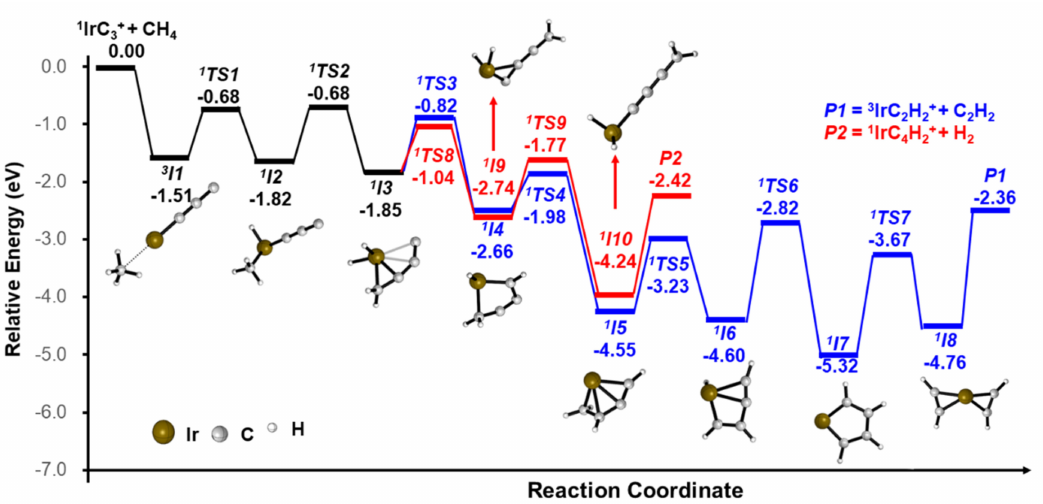
Figure 2. Reaction pathways for generating IrC 2 H 2+ /C 2 H 2 (blue trace) and IrC 4 H 2+ /H 2 (red trace) from the reaction of IrC 3+ and CH 4 , calculated at the BMK level. The zero-point vibrational energy-corrected energies (in eV) relative to the entrance channel are